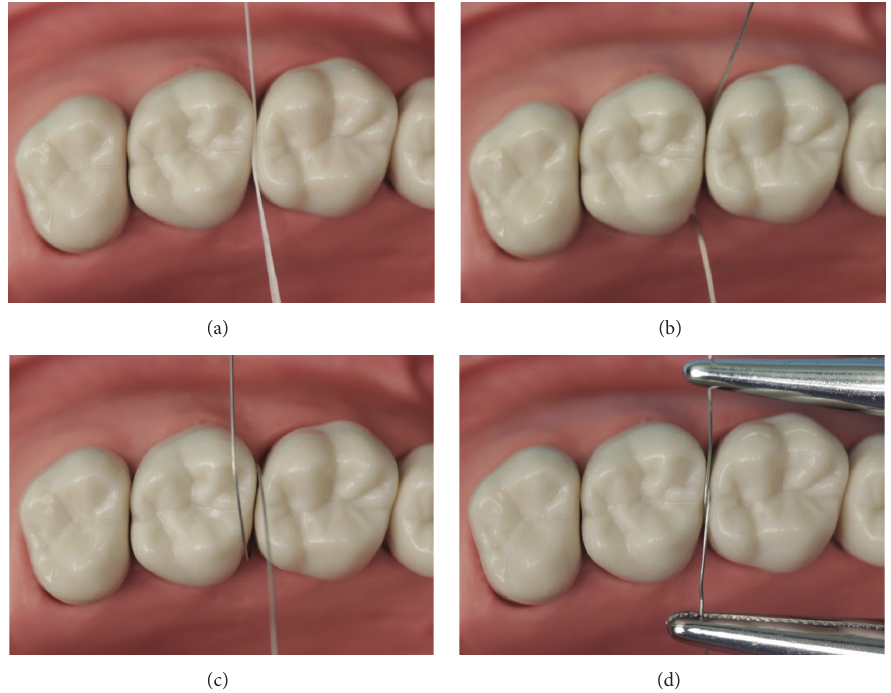
Figure2:Selectingthestainlesswirefortensionaroundthecontactarea. (a)Evaluatingthecontactarea. Unwaxeddentalflosspassedthrough the interproximal area without resistance (open contact). (b) The selected wire passed through the gingival embrasure from buccal surface to lingual surface. (c) Both ends of the wire encircled the contact area and crossed along the occlusal buccal-lingual embrasure. (d) Two hemostatic forceps were clamped to both ends of the wire to enforce buccal-lingual tensile stress, which can separate the teeth appropriately.